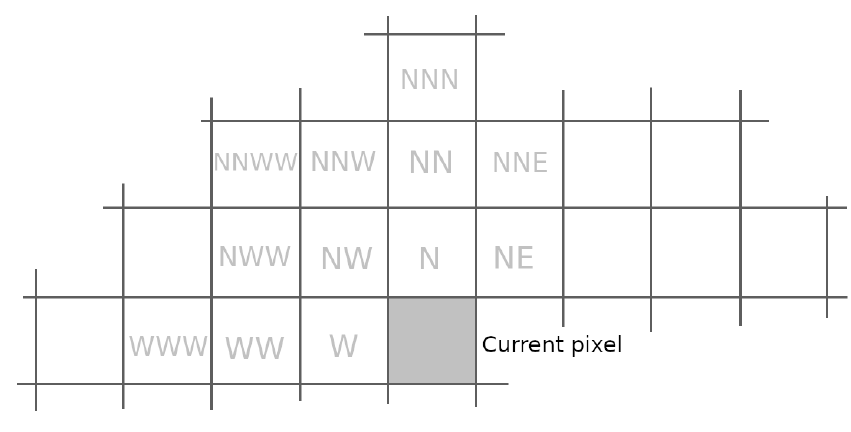
Figure 2. Causal pixel neighborhood.